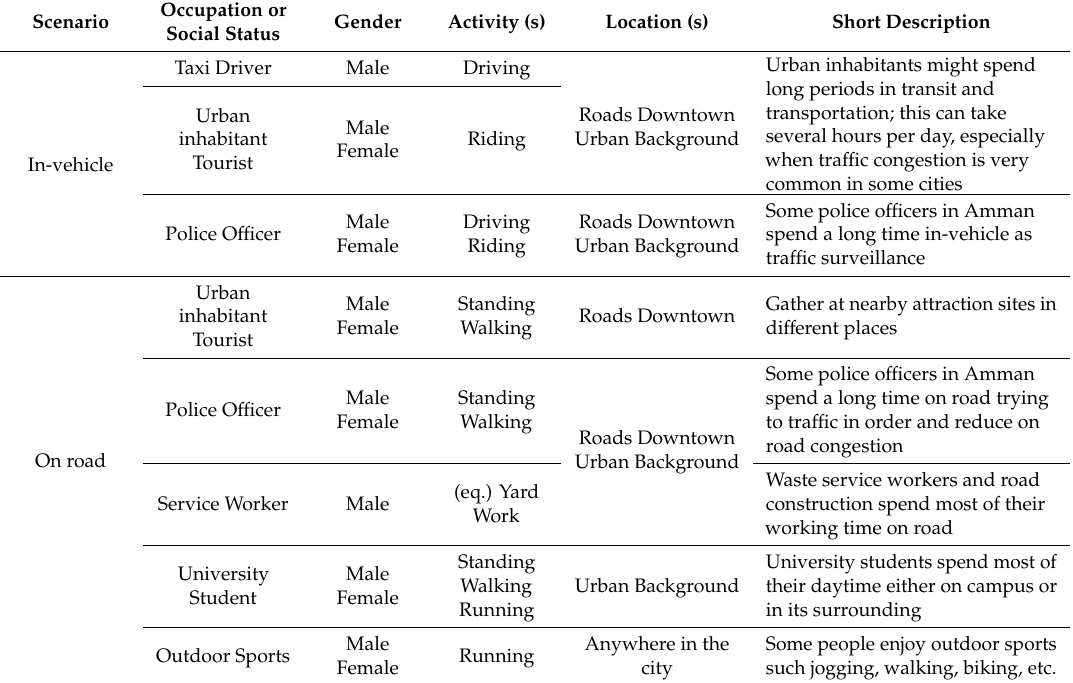
Table 3. Exposure scenarios